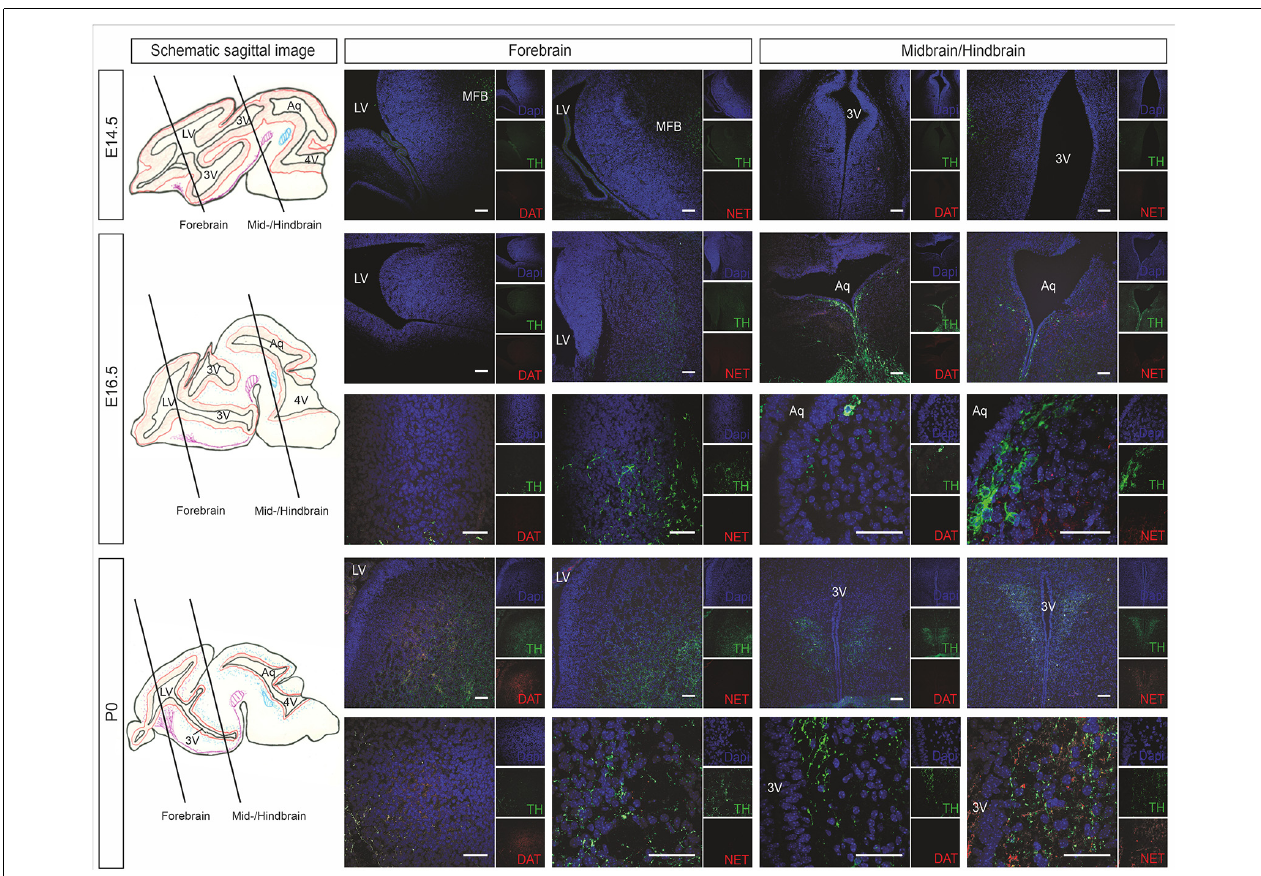
FIGURE 2 | Catecholaminergic innervation of the developing mouse brain (at developmental stages E14.5, E16.5, and P0) determined by immunostaining against the DAT and NET. The left panel shows schematic sagittal brain images illustrating the forebrain and midbrain/hindbrain sections. Representative immunohistological microphotographs of TH in green as a marker for catecholaminergic neurons as well as of DAT as a marker for dopaminergic cells and NET for norepinephrinergic cells. Lower panels in E16.5 and P0 represent individual images of forebrain or midbrain/hindbrain sections in higher magnification. Cell nuclei are counterstained with DAPI. Scale bars: 100 µ m (E14.5, upper panels of E16.5 and P0) and 50 µ m (lower panels of E16.5 and P0). 3V, third ventricle; Aq, aqueduct; DAT, dopamine transporter; LV, lateral ventricle; MFB, medial forebrain bundle; NET, norepinephrine transporter; TH, tyrosine